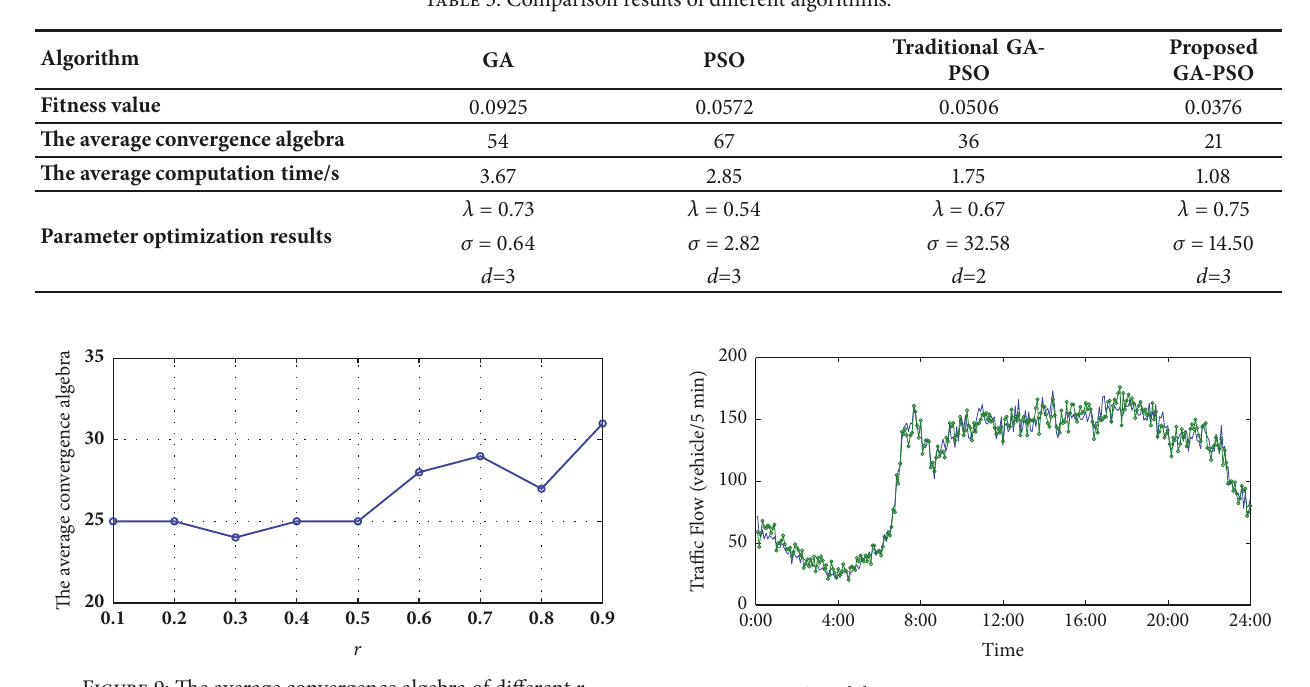
Figure 9: The average convergence algebra of different r .